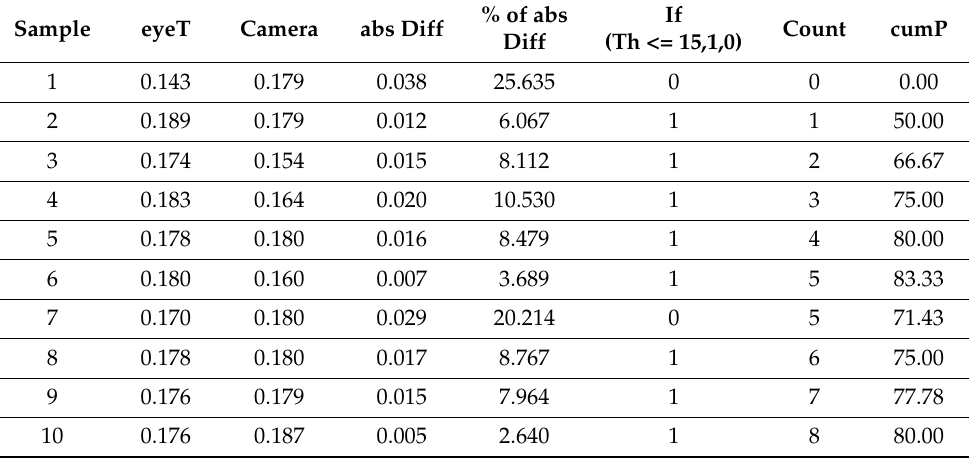
Table 3. An example to calculate